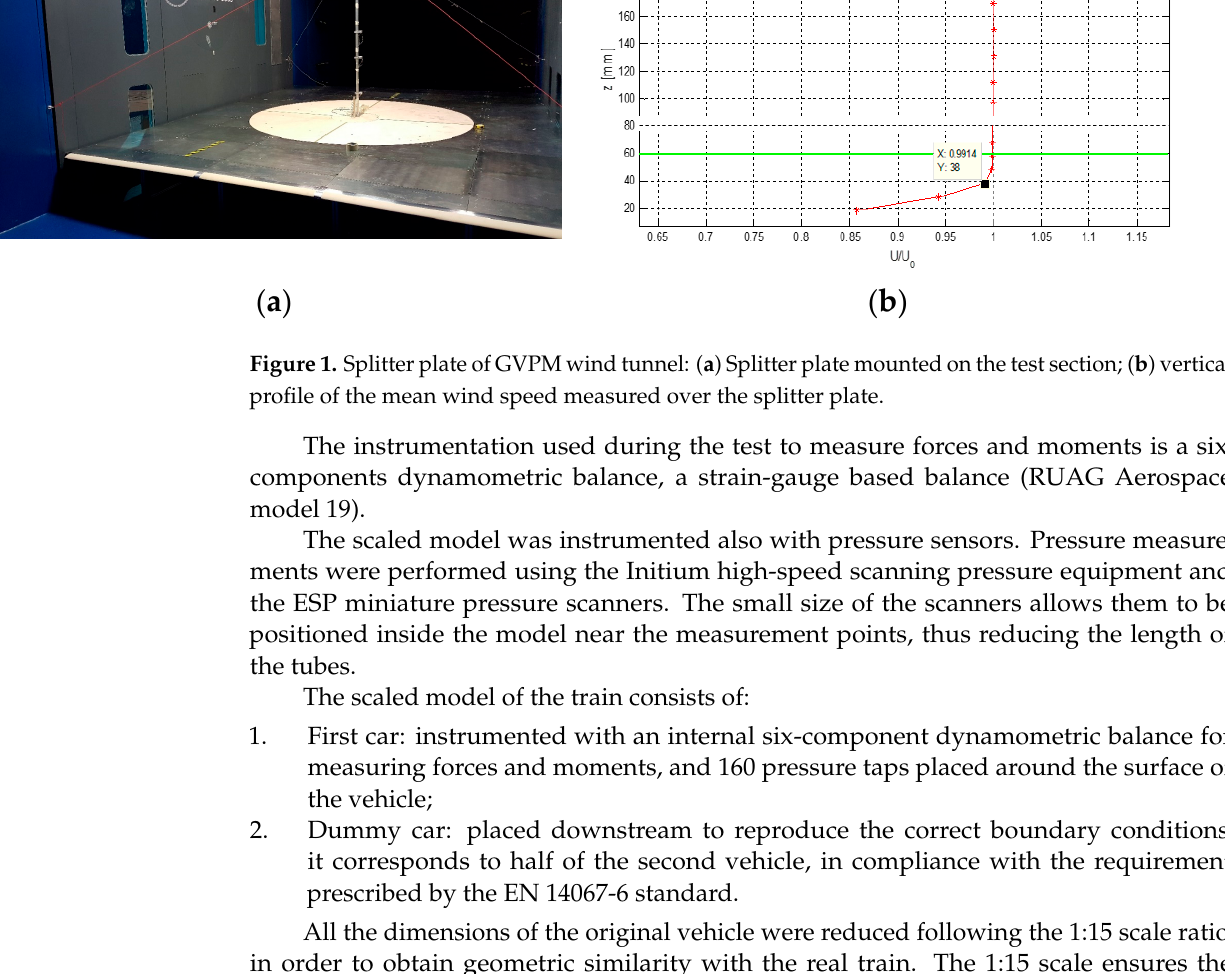
Table 1. Wind tunnel test section characteristics.